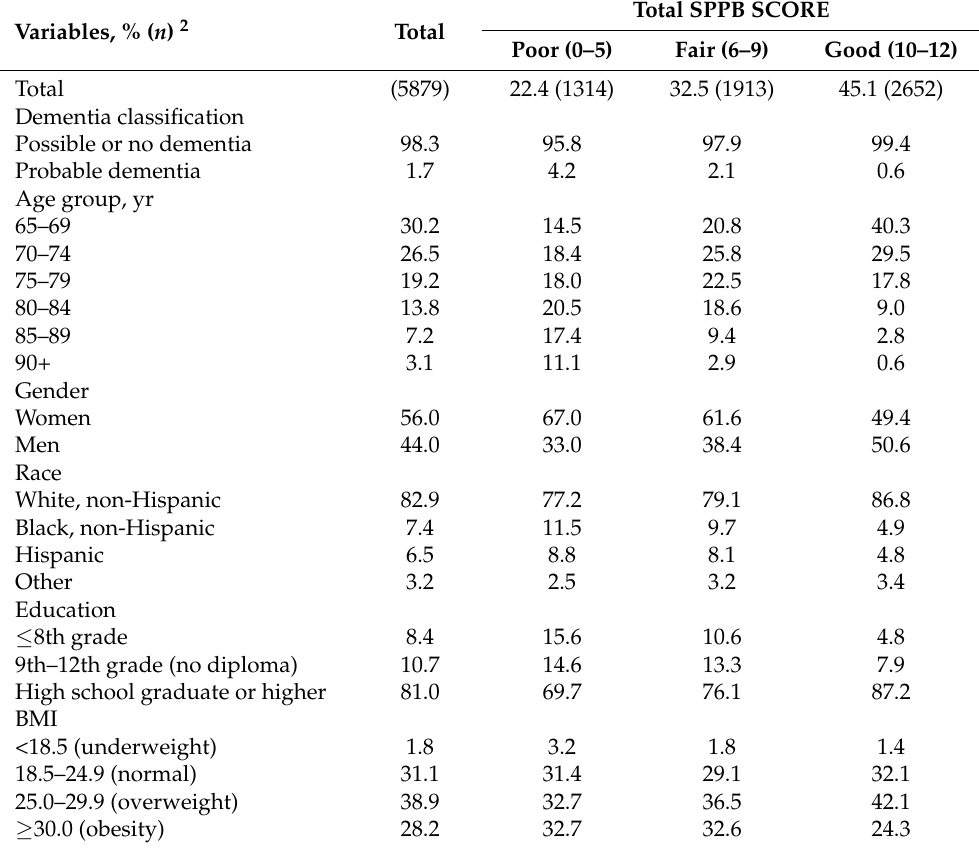
Table 1. Characteristics of Medicare beneficiaries by SPPB total score at baseline, NHATS, 2011 1 . Variables, % ( n )